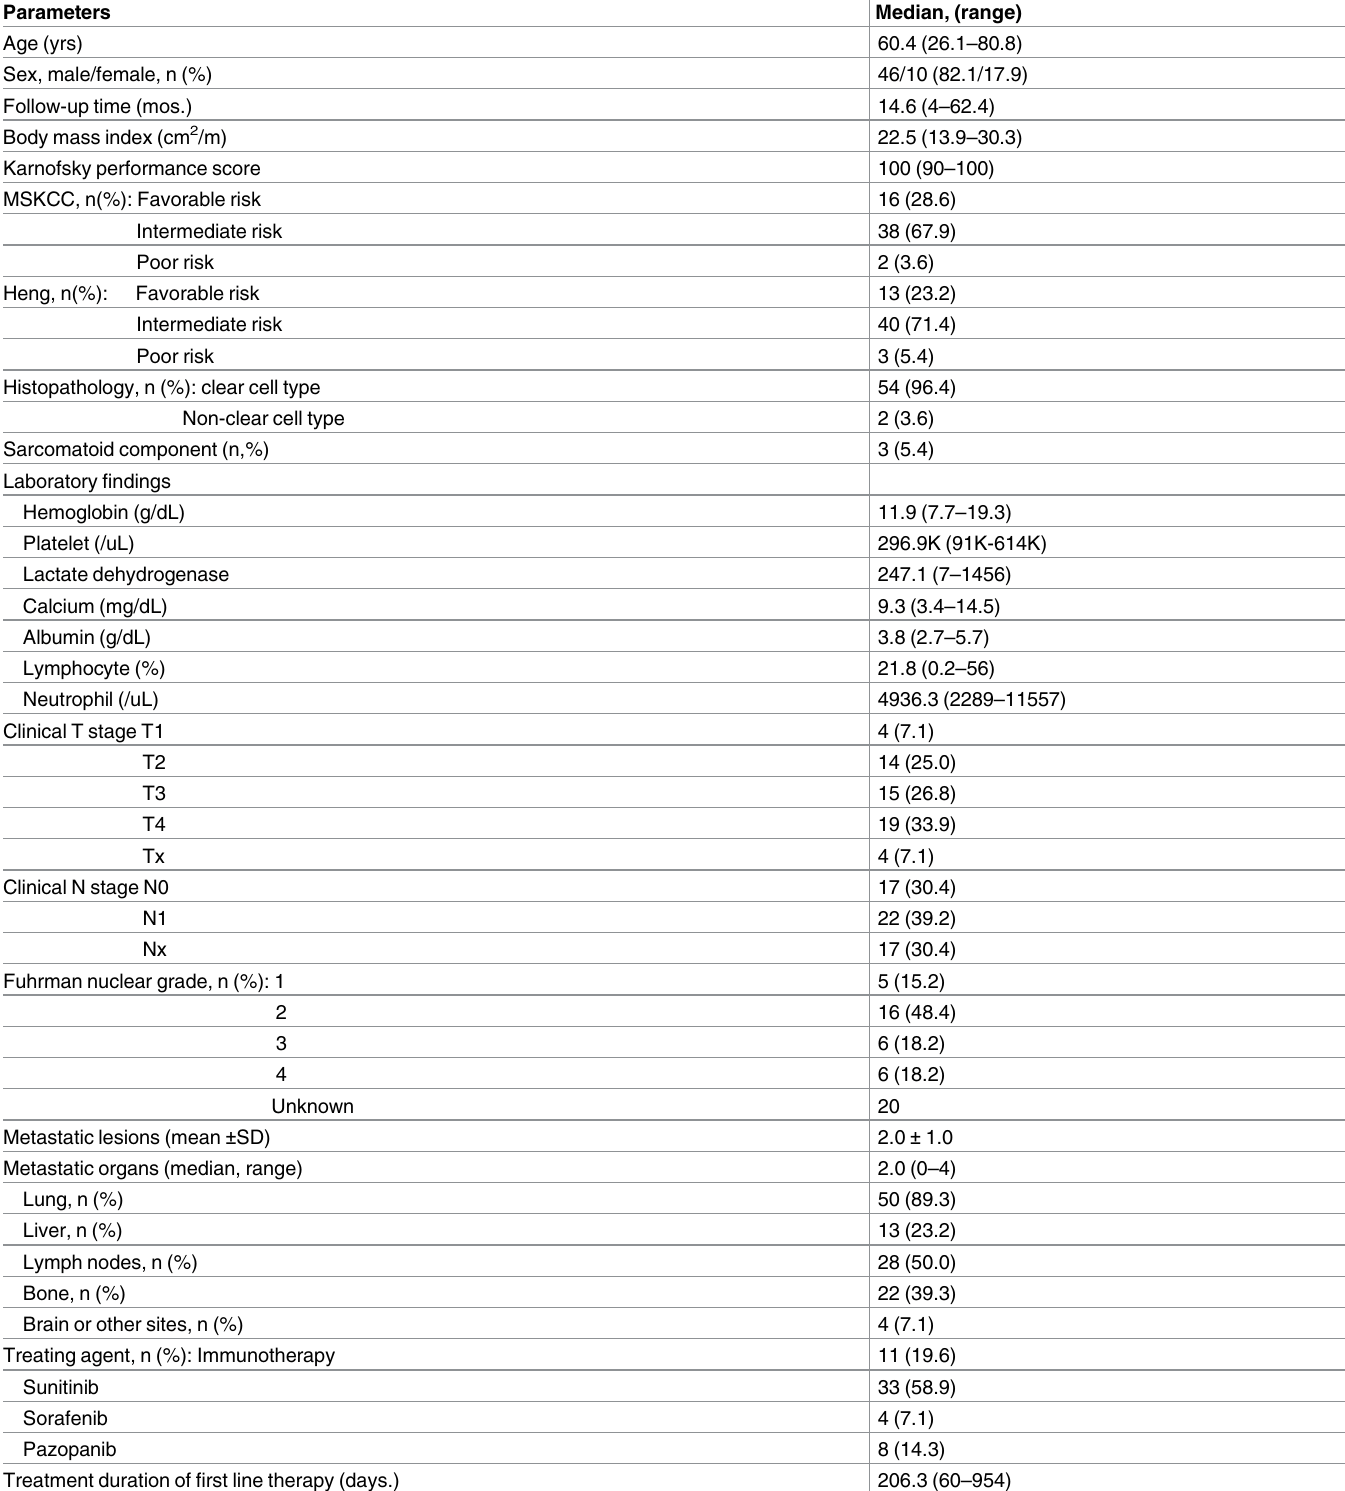
Table 1. Patient baseline demographics (N = 56 patients with 62 primary